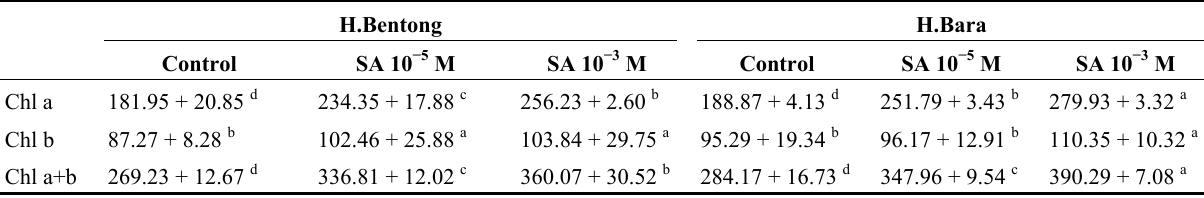
Table 2. Effect of foliar SA application (10 − 3 and 10 − 5 M) on chlorophyll content of